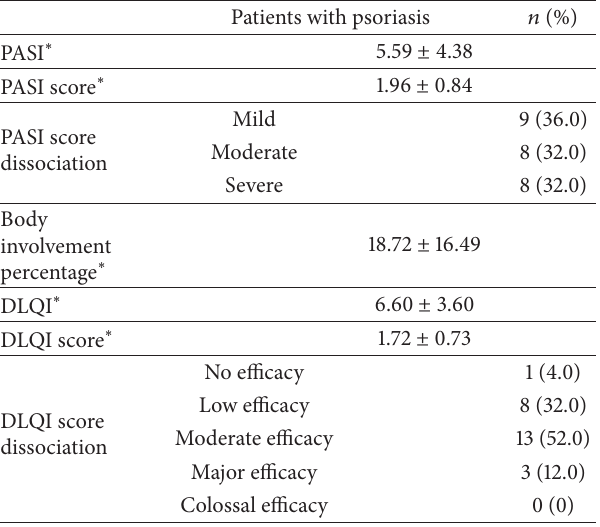
Table 2: Body involvement percentage and PASI and DLQI values of patients with psoriasis.